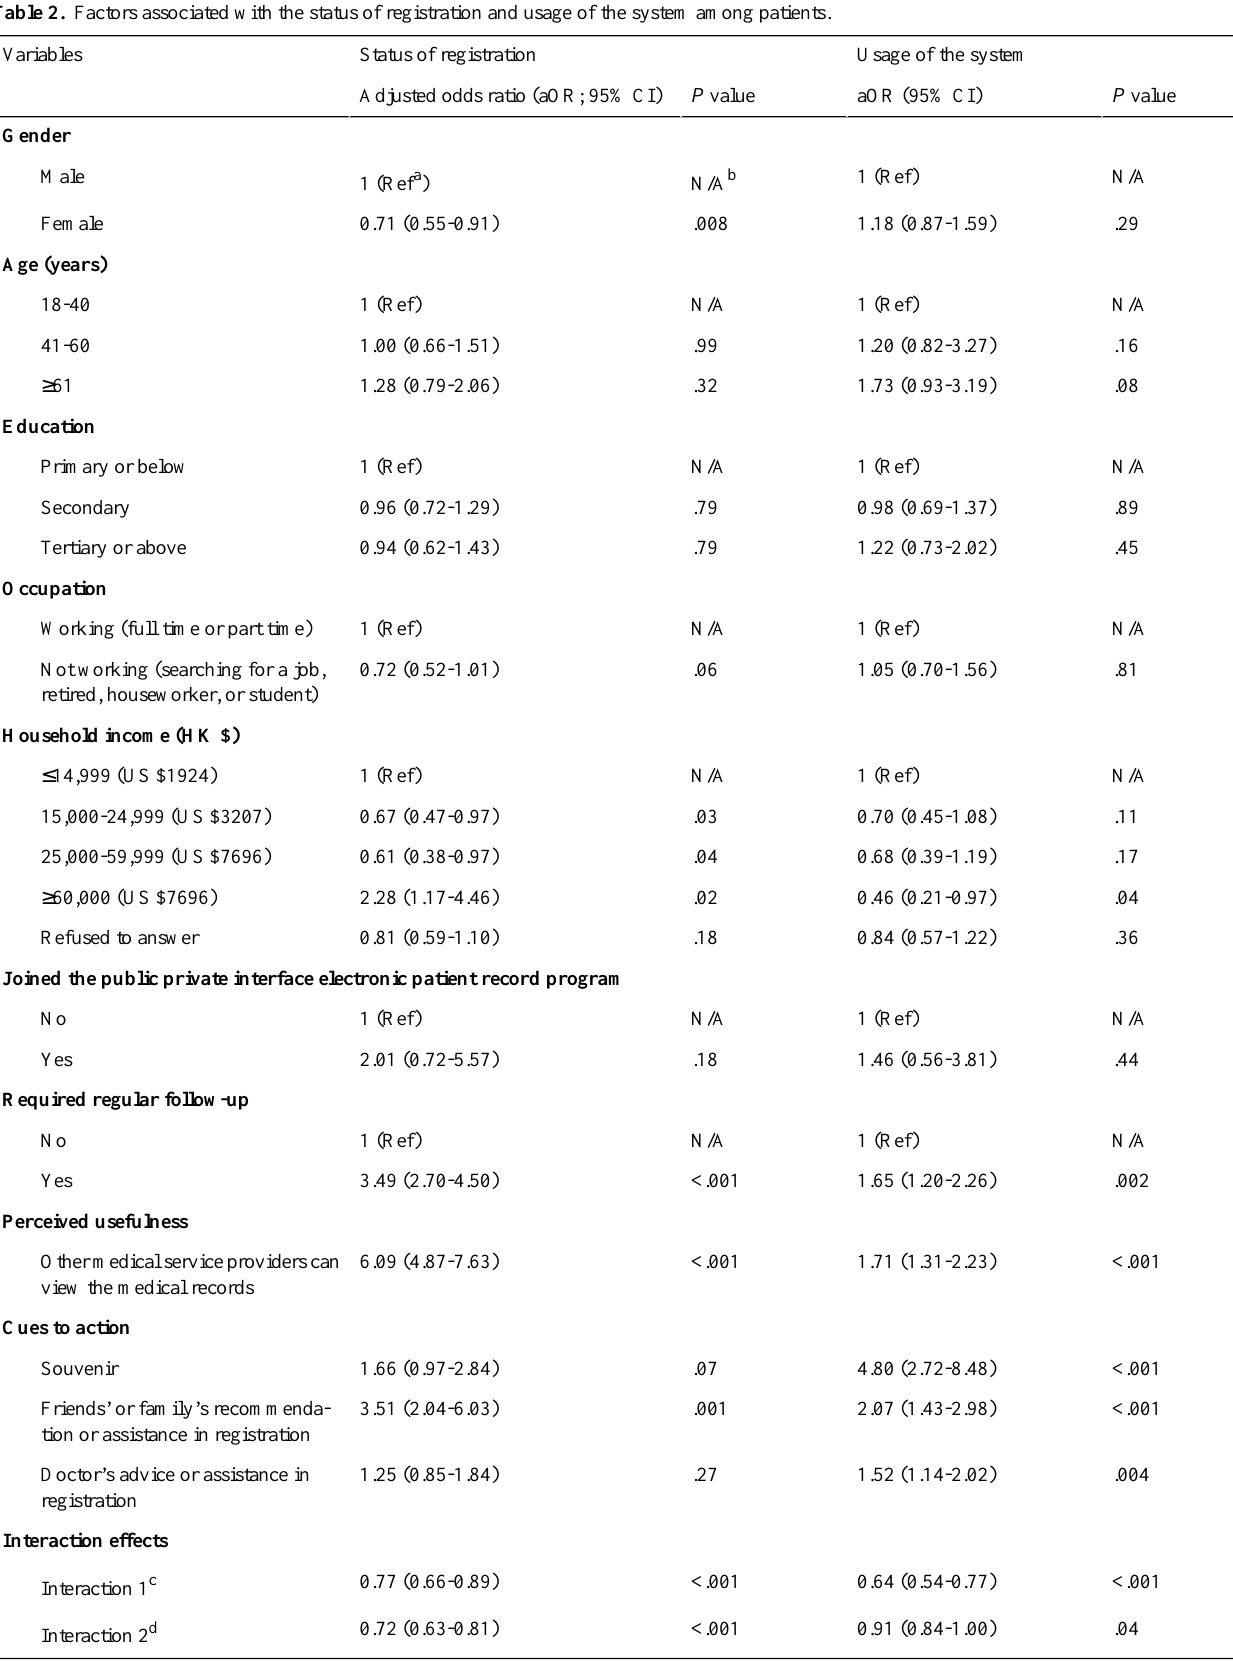
Table 2. Factors associated with the status of registration and usage of the system among patients.